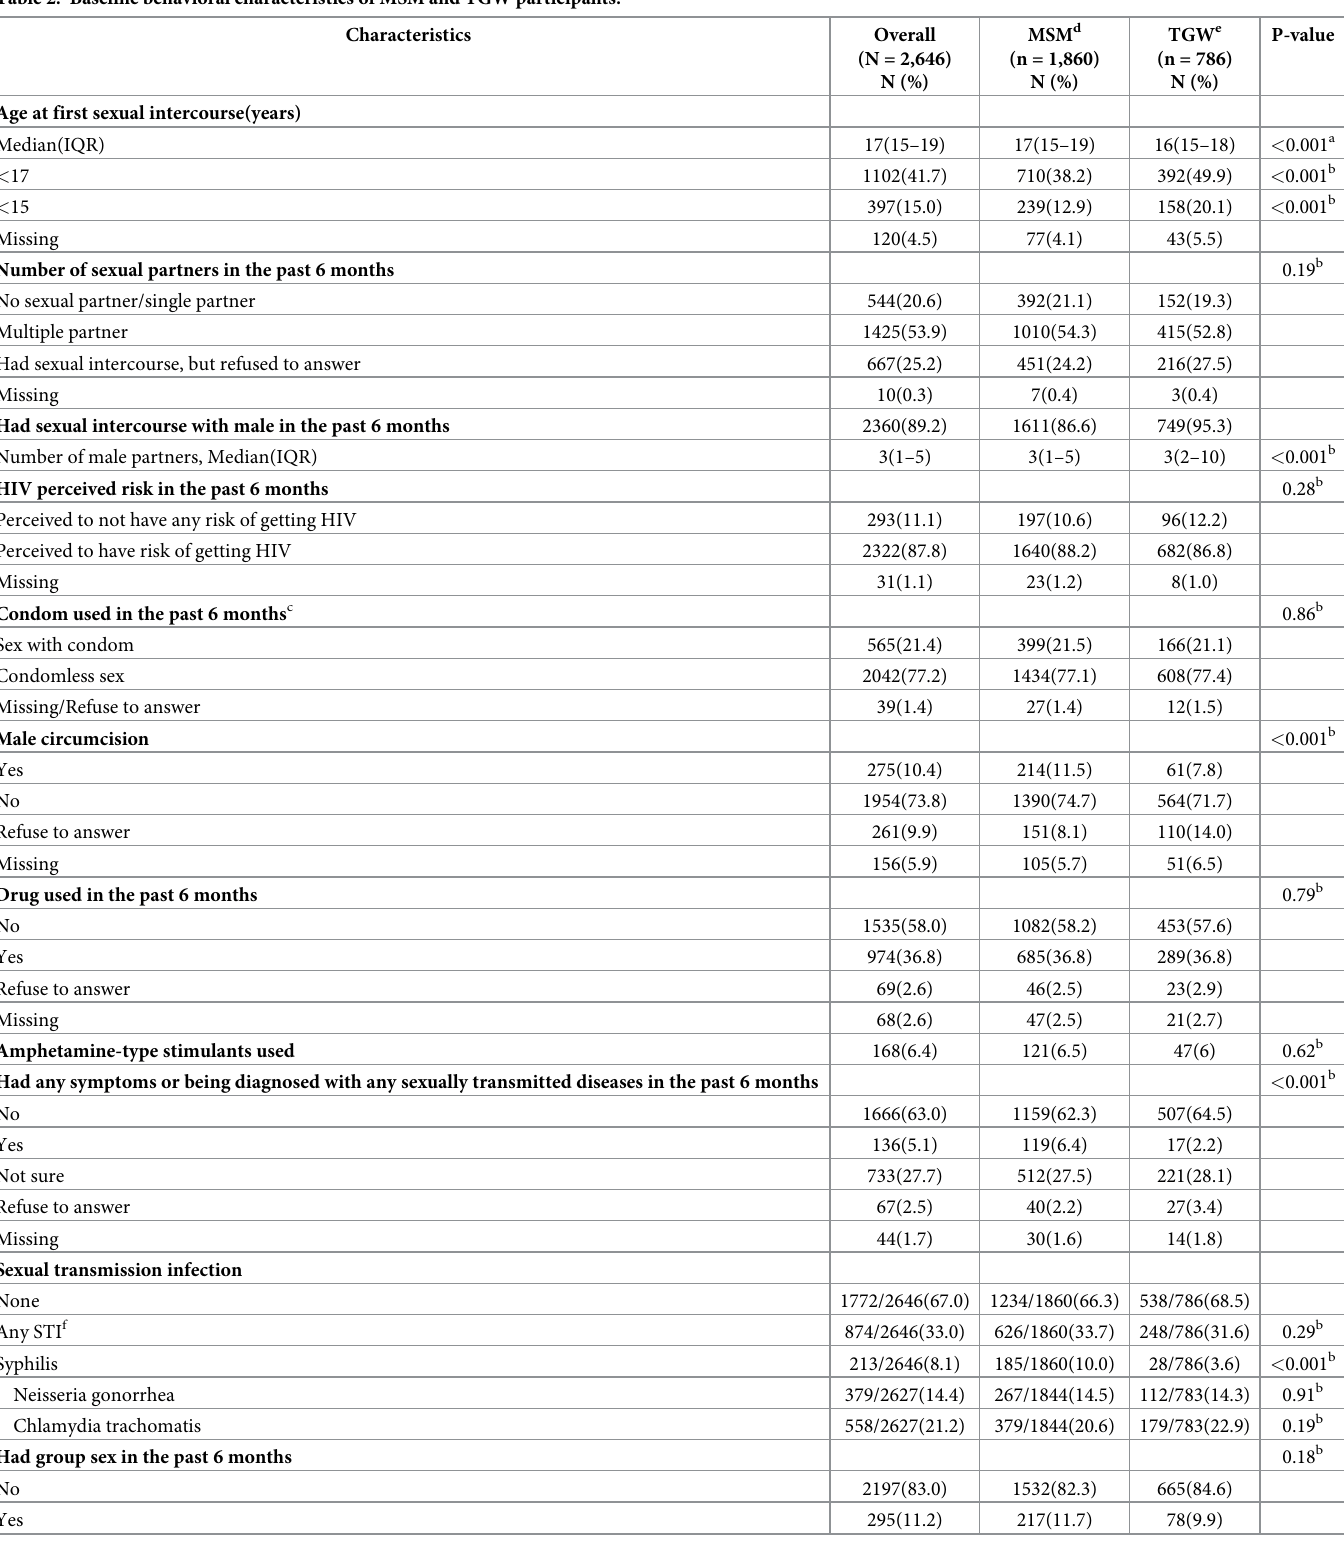
Table 2. Baseline behavioral characteristics of MSM and TGW participants.